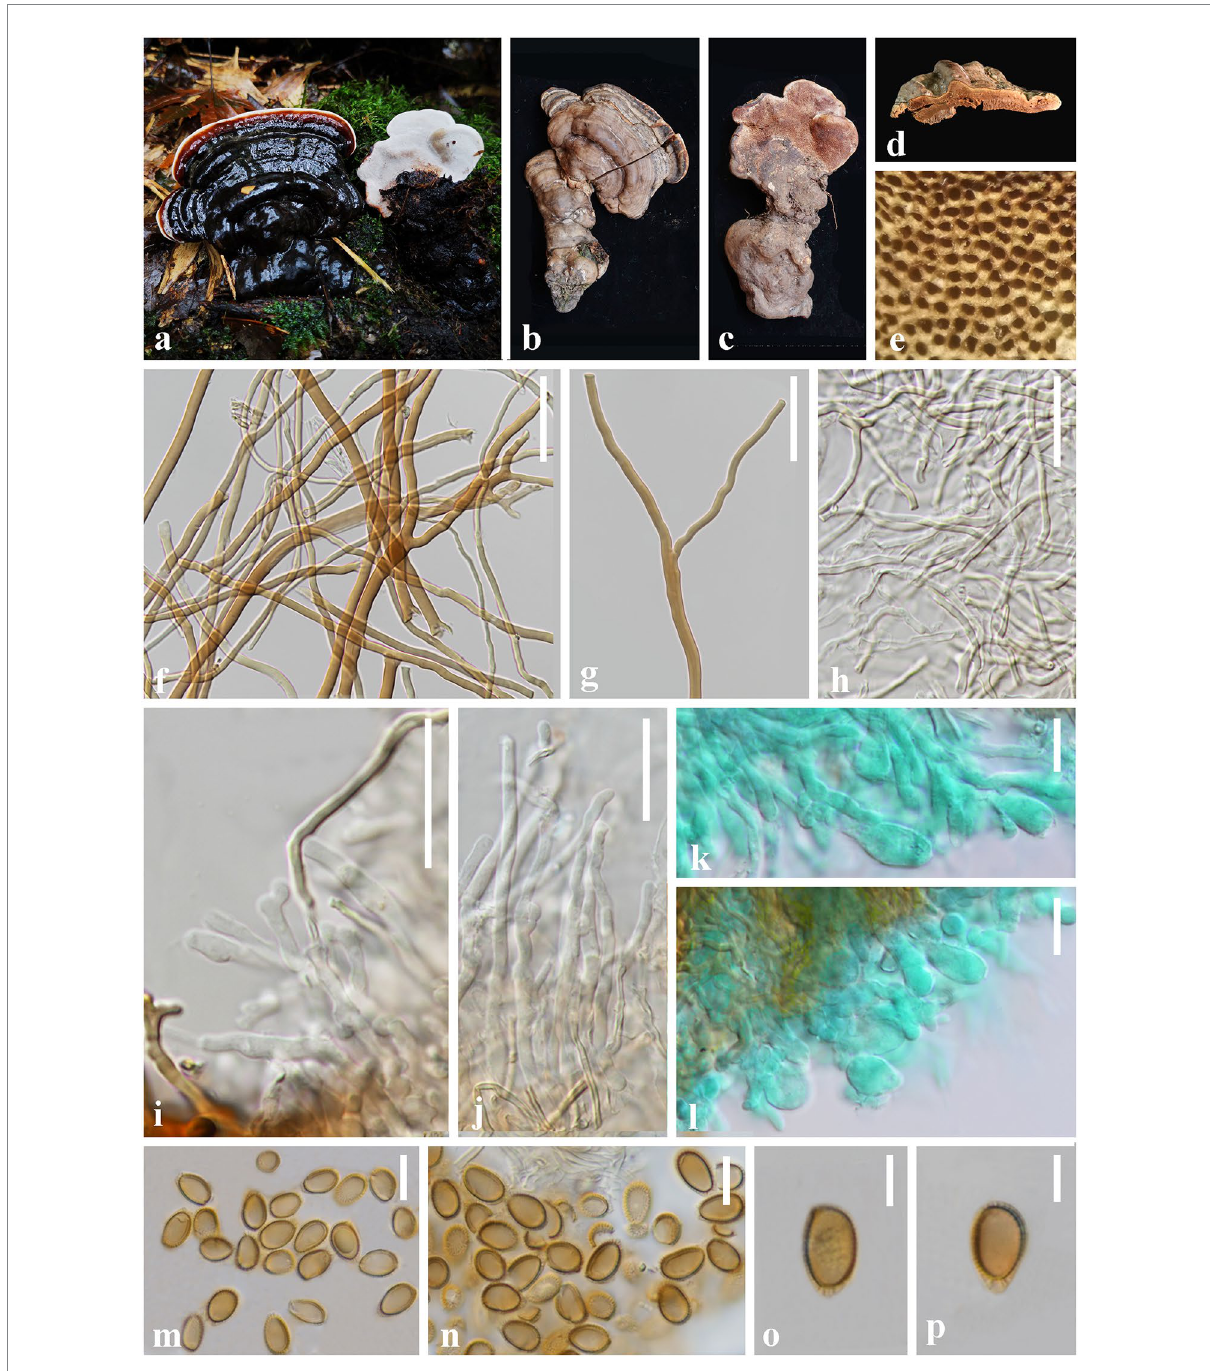
FIGURE 5 Ganoderma obscuratum (HKAS 123786, holotype) (A–C) Basidiomata. (D) Transverse section of pileus. (E) Pore surface. (F,G) Skeletal hyphae from context. (H) Binding hyphae from context. (I,J) Generative hyphae from tubes. (K,L) Basidia and basidioles. (M–P) Basidiospores. Scale bars: (F,G) = 30 μ m, (H–N) = 10 μ m, (O,P) = 5 μ m. Photographs were taken by